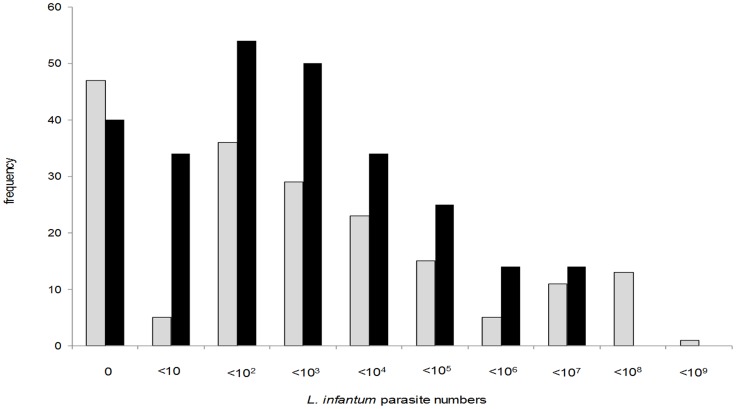
Frequency distributions of L. infantum parasite numbers in dog tissue samples measured by qPCR.Parasite numbers are expressed as numbers per mL (bone marrow, black bars) or per gram (ear skin, light bars).